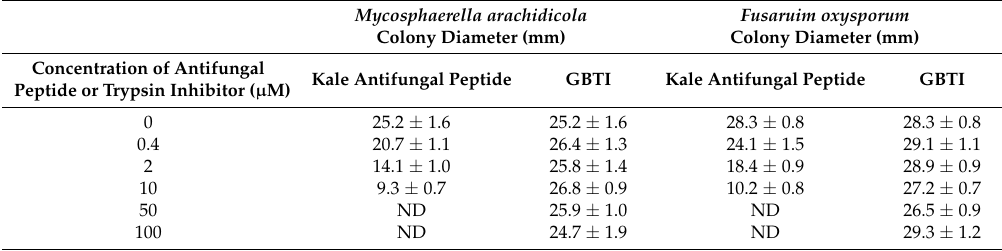
Table 6. Assay of GBTI for antifungal activity toward Mycosphaerella arachidicola and Fusaruim